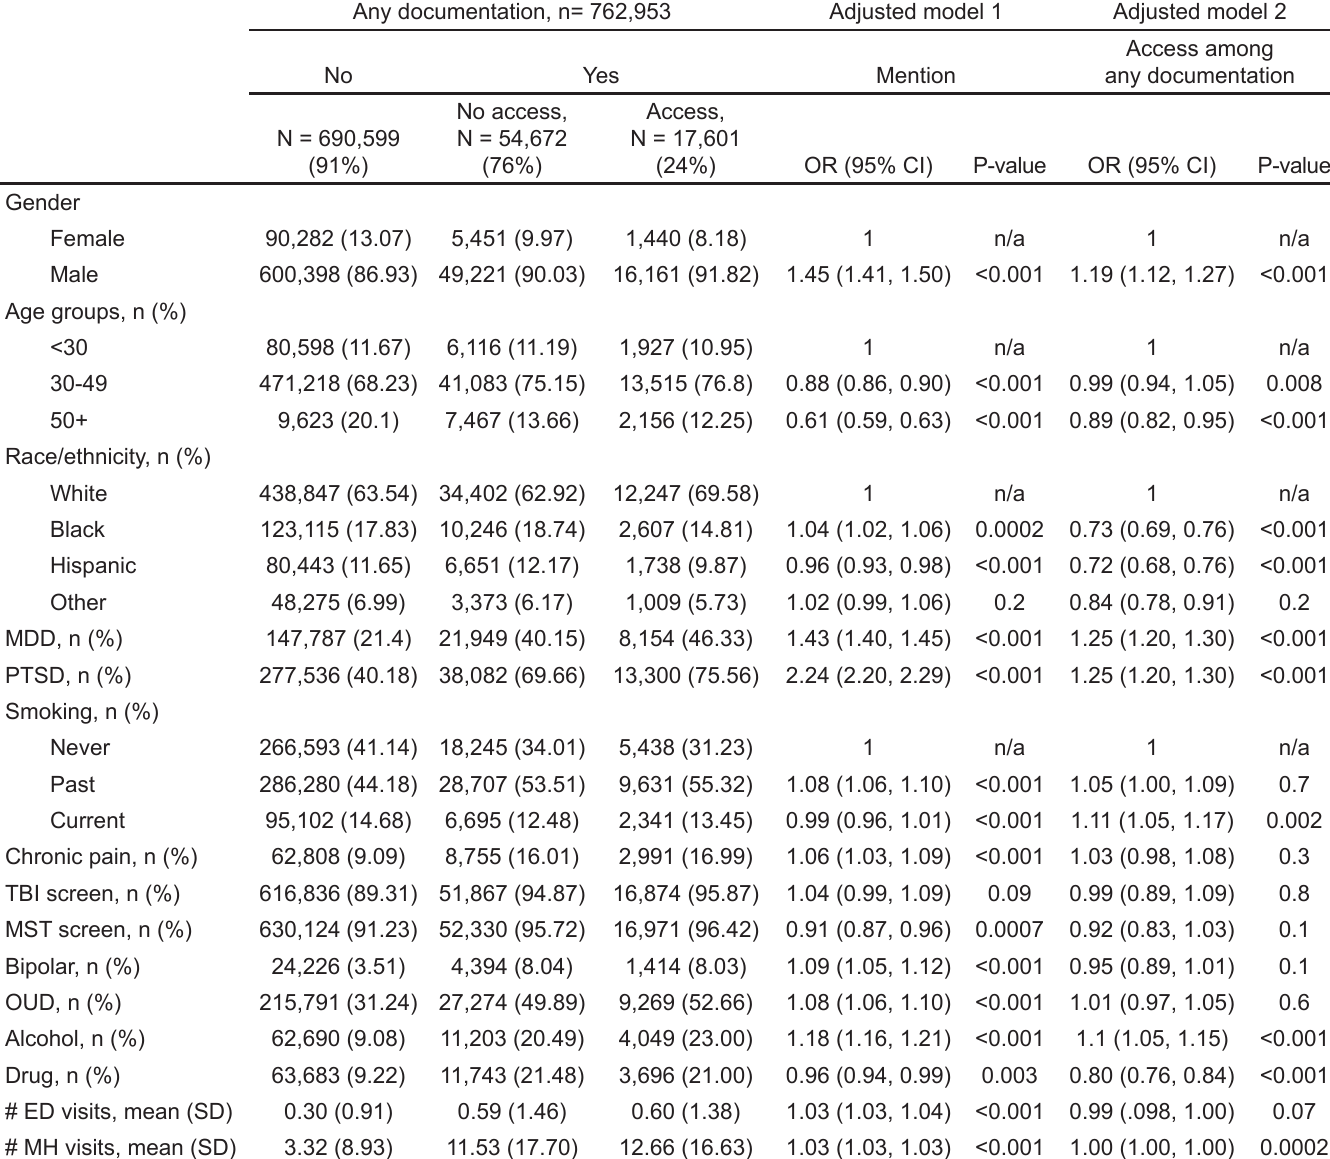
Table 2. Documentation of access to firearm by covariates with adjusted models for any firearm documentation and access.